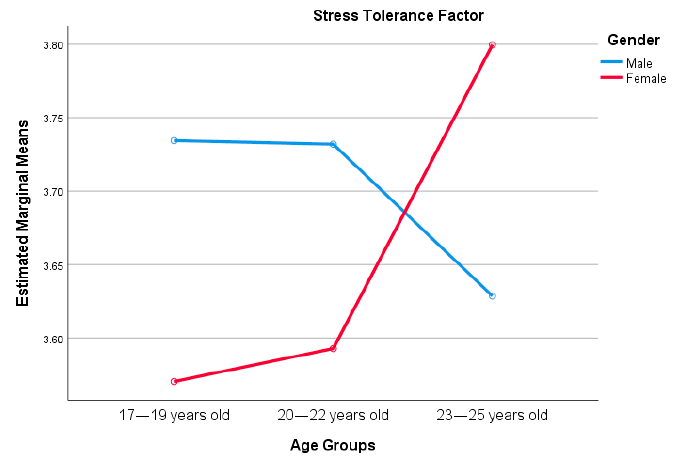
Figure 1. Interaction effect between gender and age, and resilience. Specifically, with the stress tolerance factor.